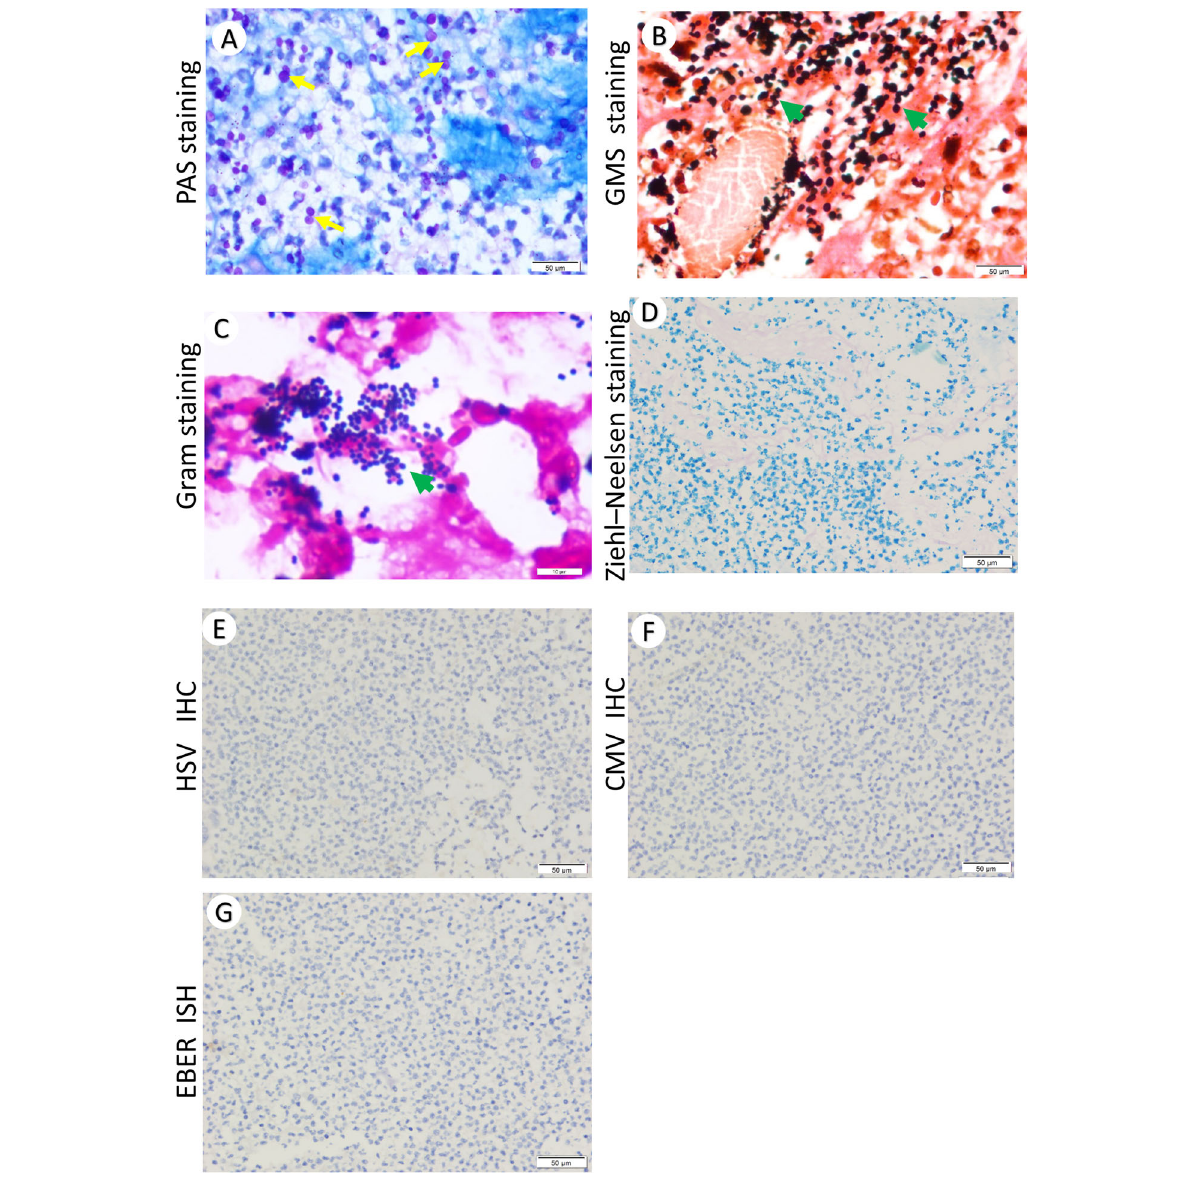
Fig. 2 Possible microbiological infections in the intestinal tissue. a Fungal spores (purple red, yellow arrows) but without pseudohypha were identified by PAS staining (400X), b Fungal spores (black, green arrows) were identified by GMS staining (400X), c Gram staining revealed positive cocci (purple, green arrow, 1000X). d Ziehl – Neelsen stain (400X) did not identified Mycobacterium tuberculosis . Immunohistochemistry of HSV ( e 400X) and CMV ( f 400X) and in situ hybridization of EBV ( g 400X) did not showed